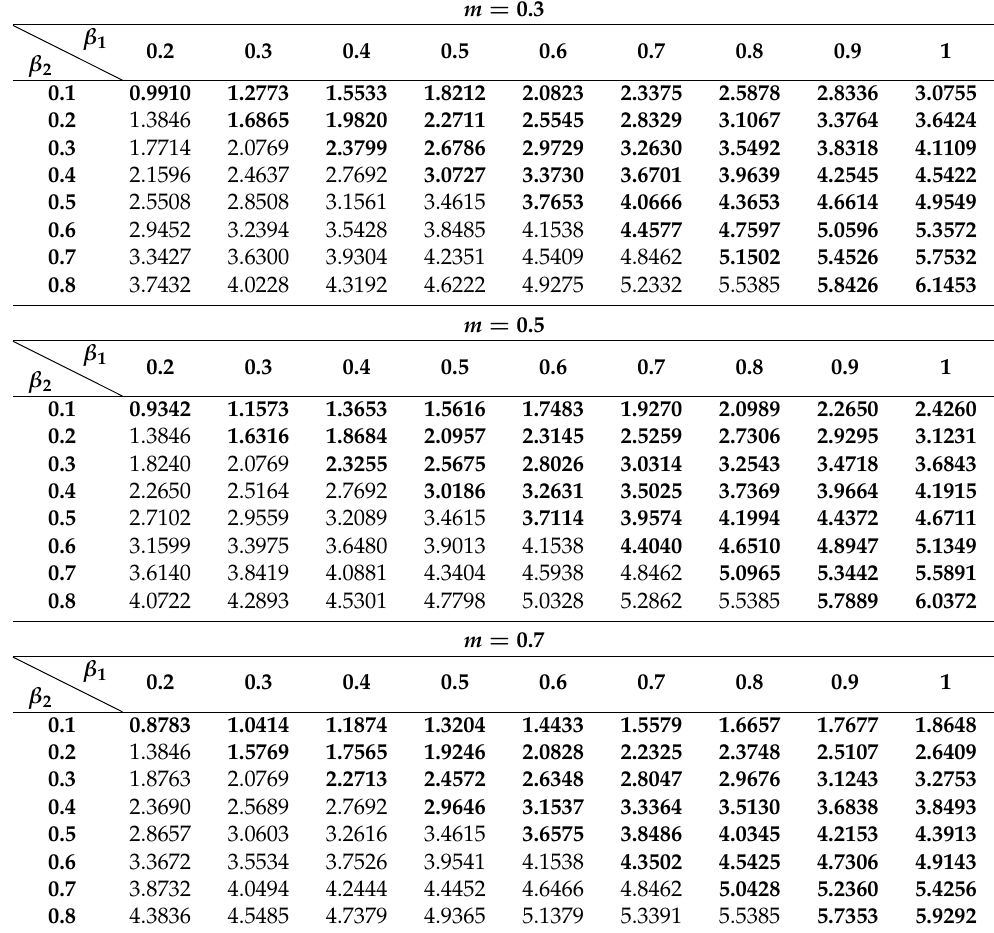
Table A3. Changes in the expected outcome of the